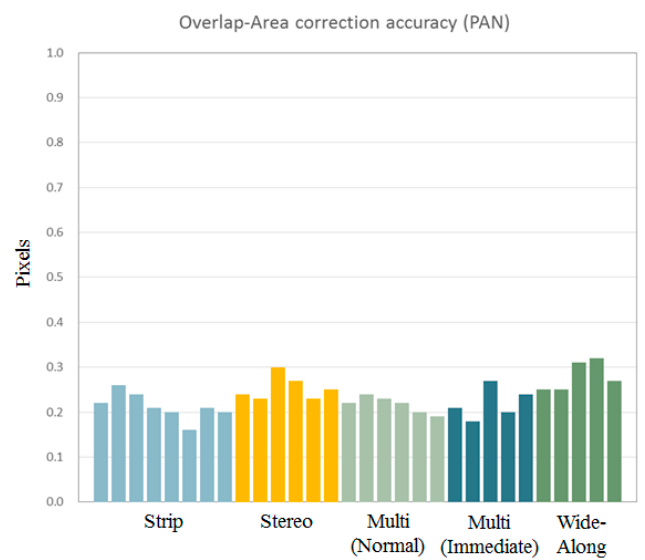
Figure 10. Discrepancy between subimages after the merge for various image acquisition modes.